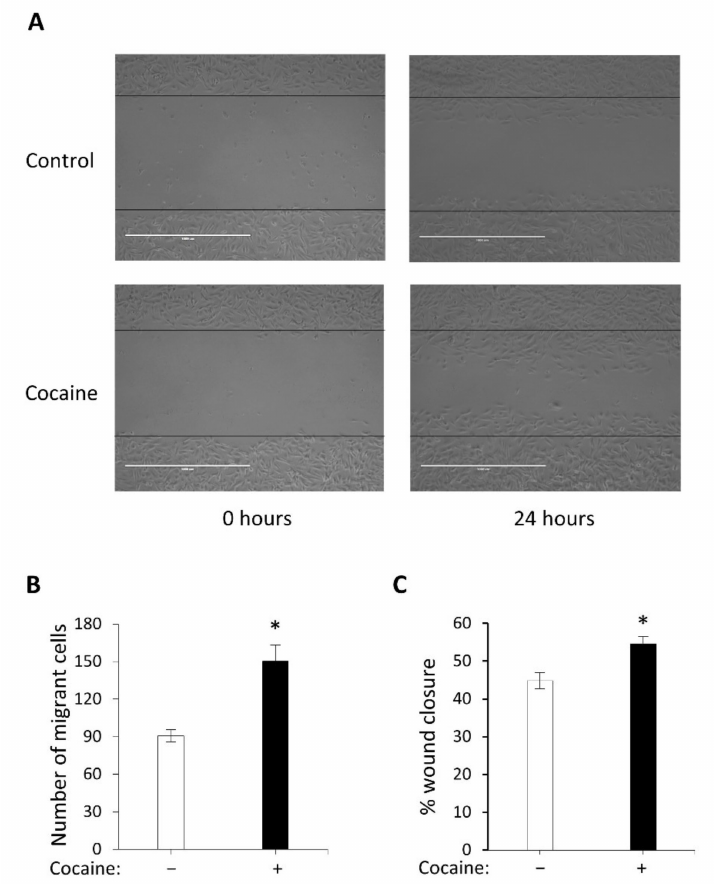
Figure 2. H9c2 cardiomyocyte migration following cocaine treatment. ( A ) H9c2 cardiomyocytes were exposed to complete growth medium or 1 µ g/mL cocaine treatments for 24 h. ( B ) Migrant cells were quantified by Image J analysis and compared against non-treated cells. ( C ) Cell wound penetration levels were determined manually by equivalence of the scale bar and compared against non-treated cells. All data represent mean values ± SEM of three independent experiments ( n = 6, for each data group on a six-well transparent culture plate). Statistical comparison was performed by a two-tailed Students unpaired t-test, * p < 0.05 for treated vs control. Images representative of three independent experiments (scale bar 1000 µ